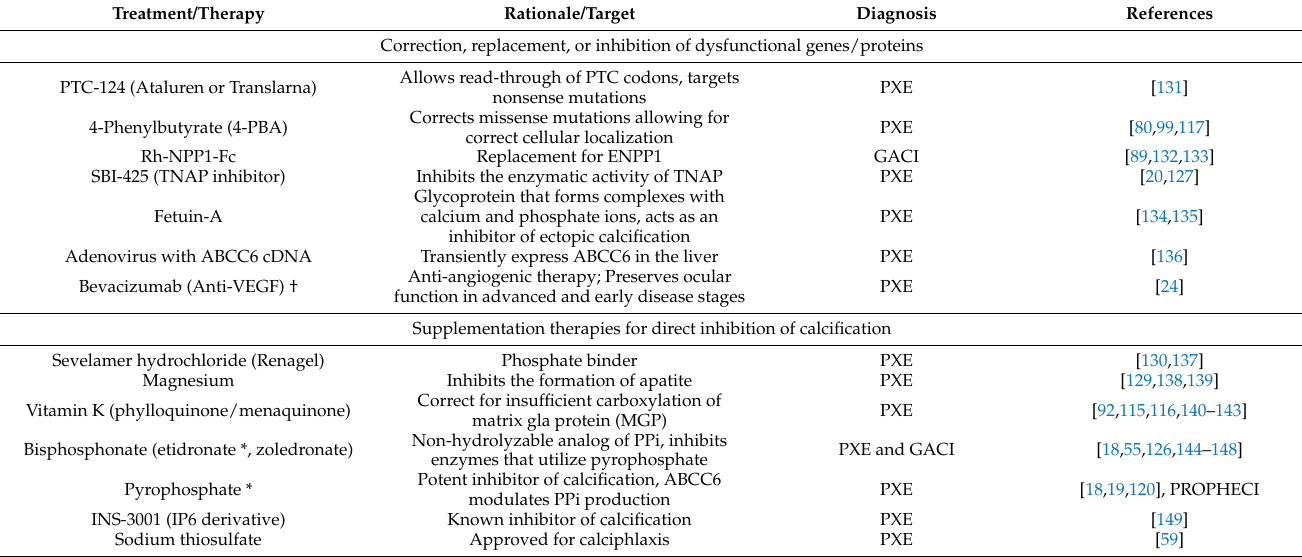
Table 1. Preclinical studies and early clinical trials for PXE (and GACI).